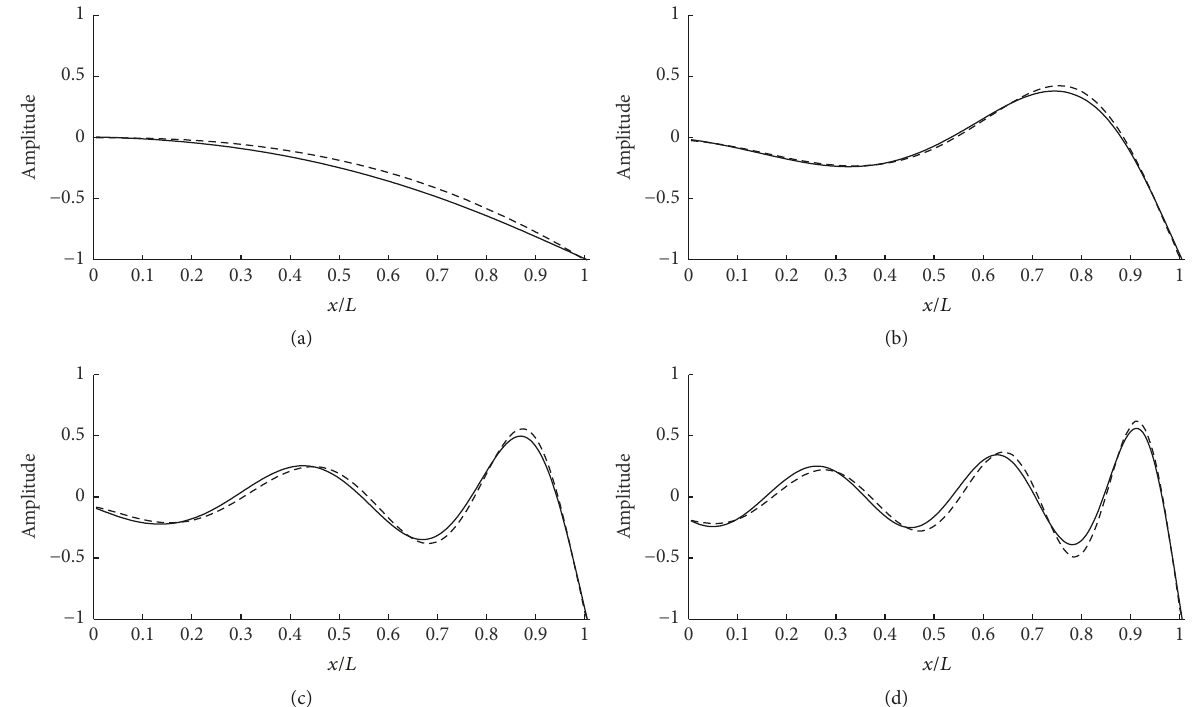
Figure 10: Selected modes of natural vibrations: (a) I mode, (b) III mode, (c) V mode, and (d) VII mode (experimental data: dashed line, computational data: continuous line).